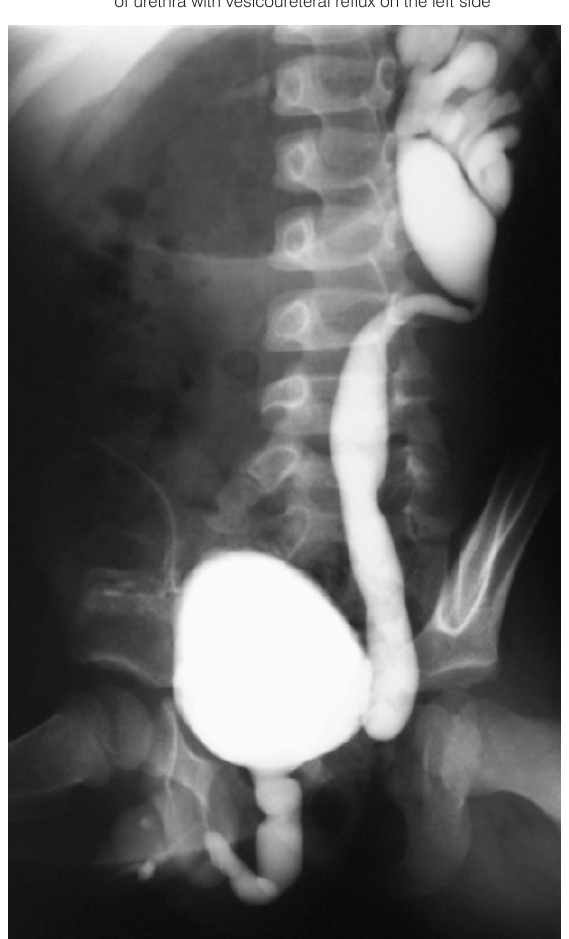
Figure 1. Voiding cystourethrogram: dilated proximal part of ure- thra and abrupt change of urethral caliber at the distal part of urethra with vesicoureteral reflux on the left side